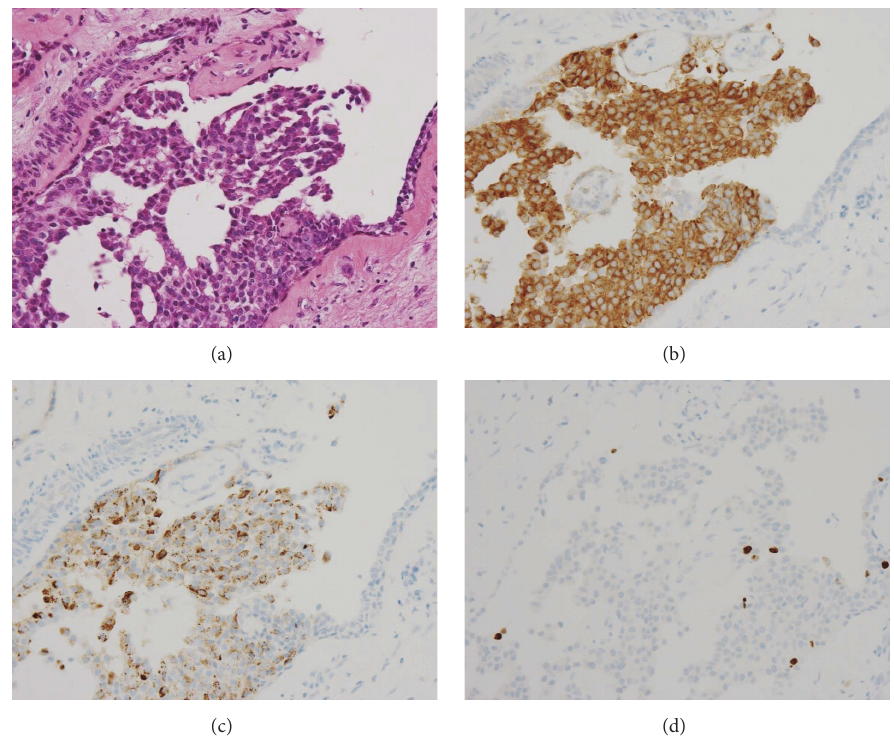
Figure 5: (a) The tumor cells show a solid papillary growth pattern (HE stain, original magnification × 400). (b) The tumor cells show positive immunoreactivity for synaptophysin (Immunohistochemistry, original magnification × 400). (c) The tumor cells show positive immunoreactivity for chromogranin A (Immunohistochemistry, original magnification × 400). (d) A few tumor cells show positive